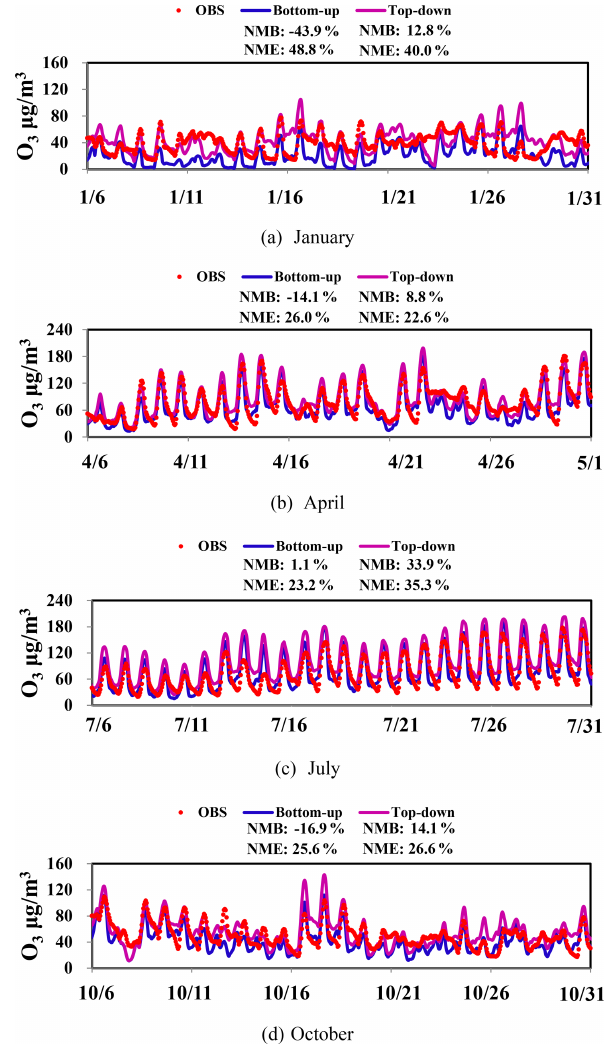
Figure 6. The observed and simulated hourly O 3 concentrations with the bottom-up and top-down NO x emission estimates for Jan- uary, April, July, and October 2016.